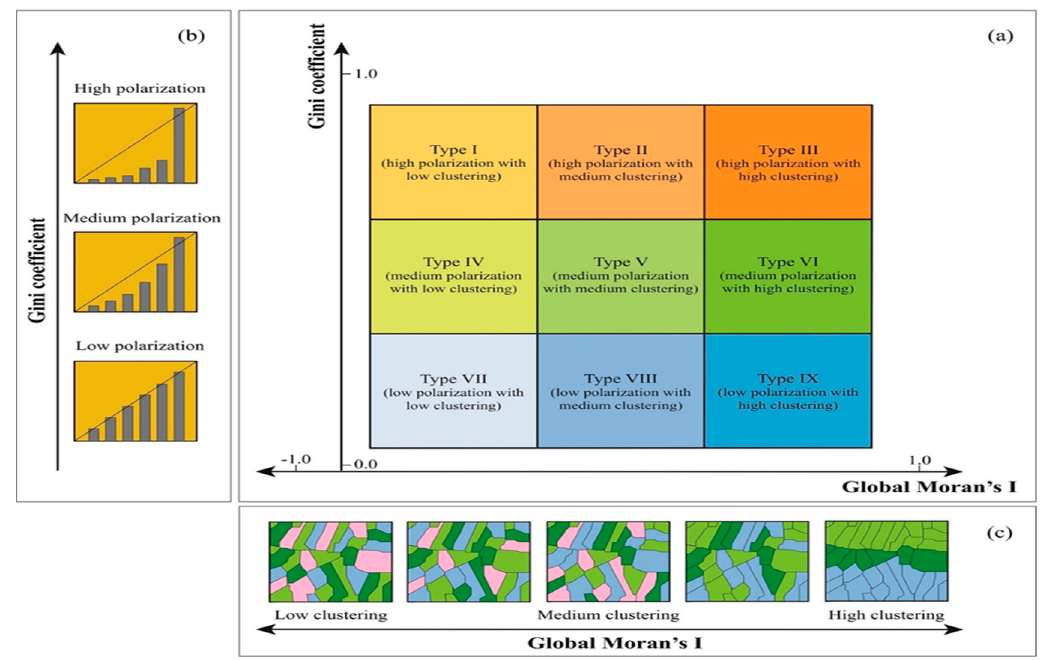
Figure 2. City type classification according to Jenks. Sub-figure ( a ) is city type categories, ( b ) is polarization level and ( c ) is level of clustering.